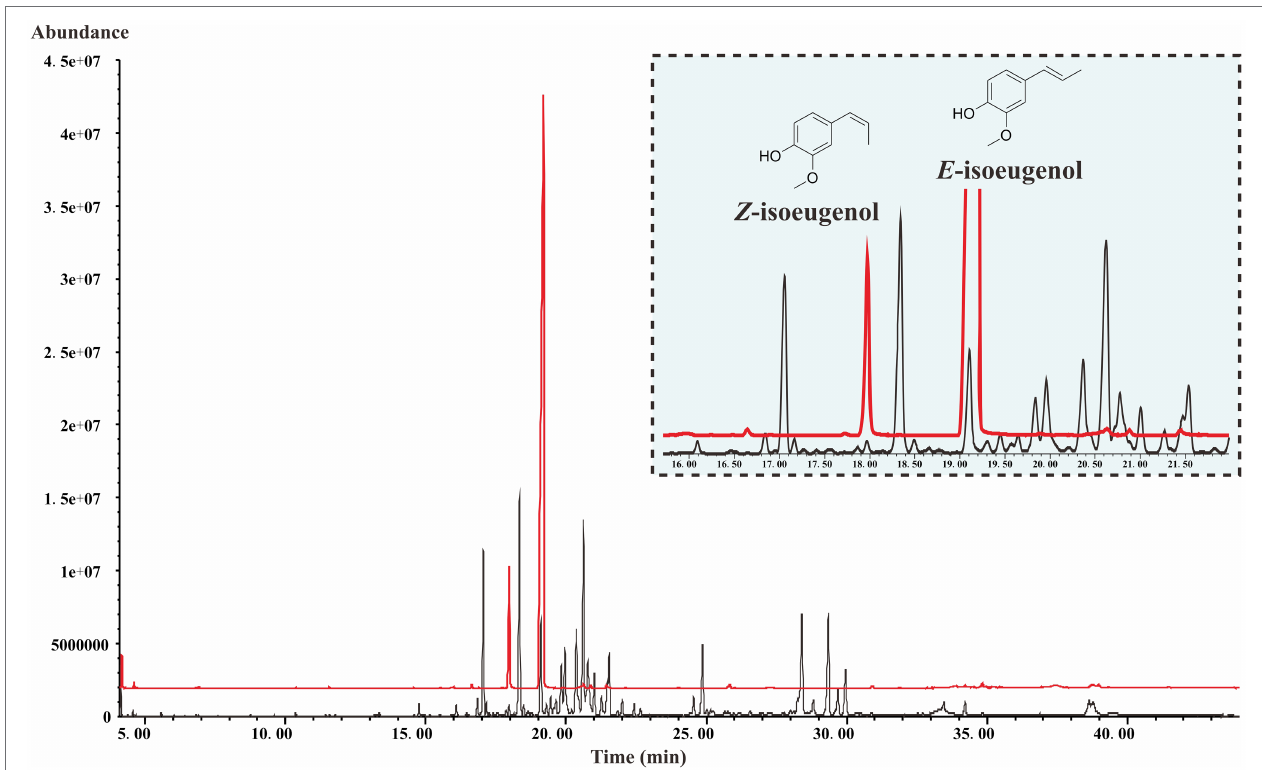
FIGURE 2 | The TIC of the isoeugenol standard and the fruits of S. chinensis